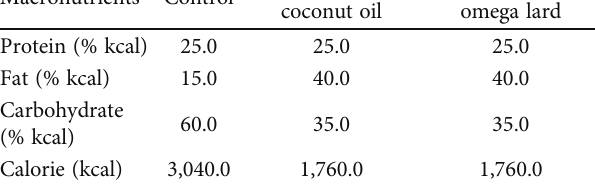
Table 2: Macronutrient energy distribution of diets used in this